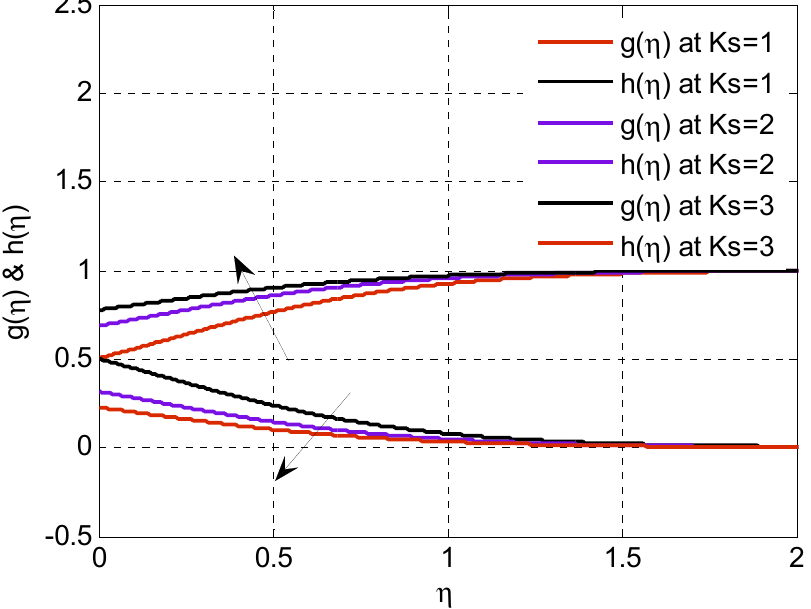
Figure 14. Effect of heterogeneous reaction parameter on concentration profiles of species A and B using G = 1, K b = 1, λ = 0.5, F r = 0.1, K = 1, δ = 1, S c = 4, and N = 3040 .